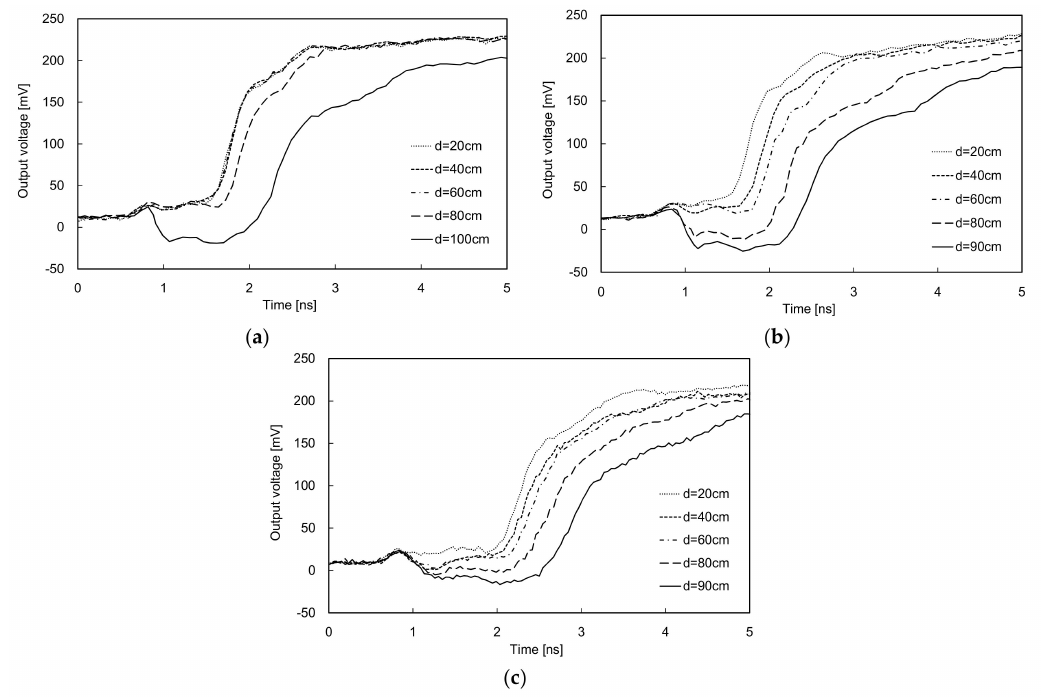
Figure 7. TDR waveforms measured in the field along the penetration depth: ( a ) P1; ( b ) P2; and ( c )